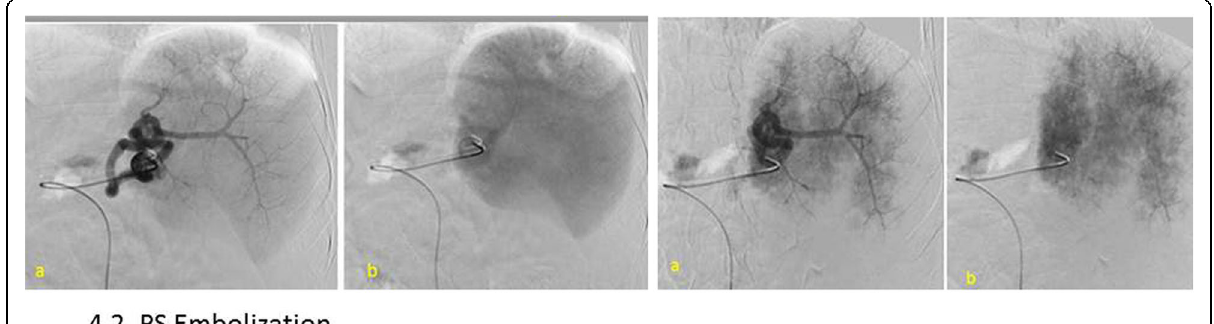
Fig. 8 PSE. Selective digital subtraction splenic angiography. a , b DSA of the splenic artery showing the tortuous splenic artery. The tip of the catheter reaching as distal as possible nears the splenic hilum. DSA. a , b Splenic angiography post-embolization showing multiple areas of splenic infarctions (mainly peripherally located) representing about 50% of the splenic parenchyma